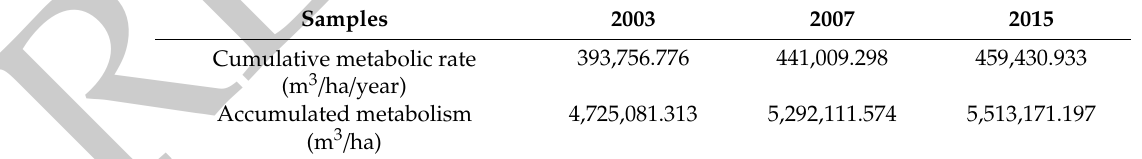
Figure 11. Material cumulative metabolic rate of all circular samples during 2003–2015. Table 3. Material cumulative metabolic rate and total accumulated metabolism from 2003 to 2015.